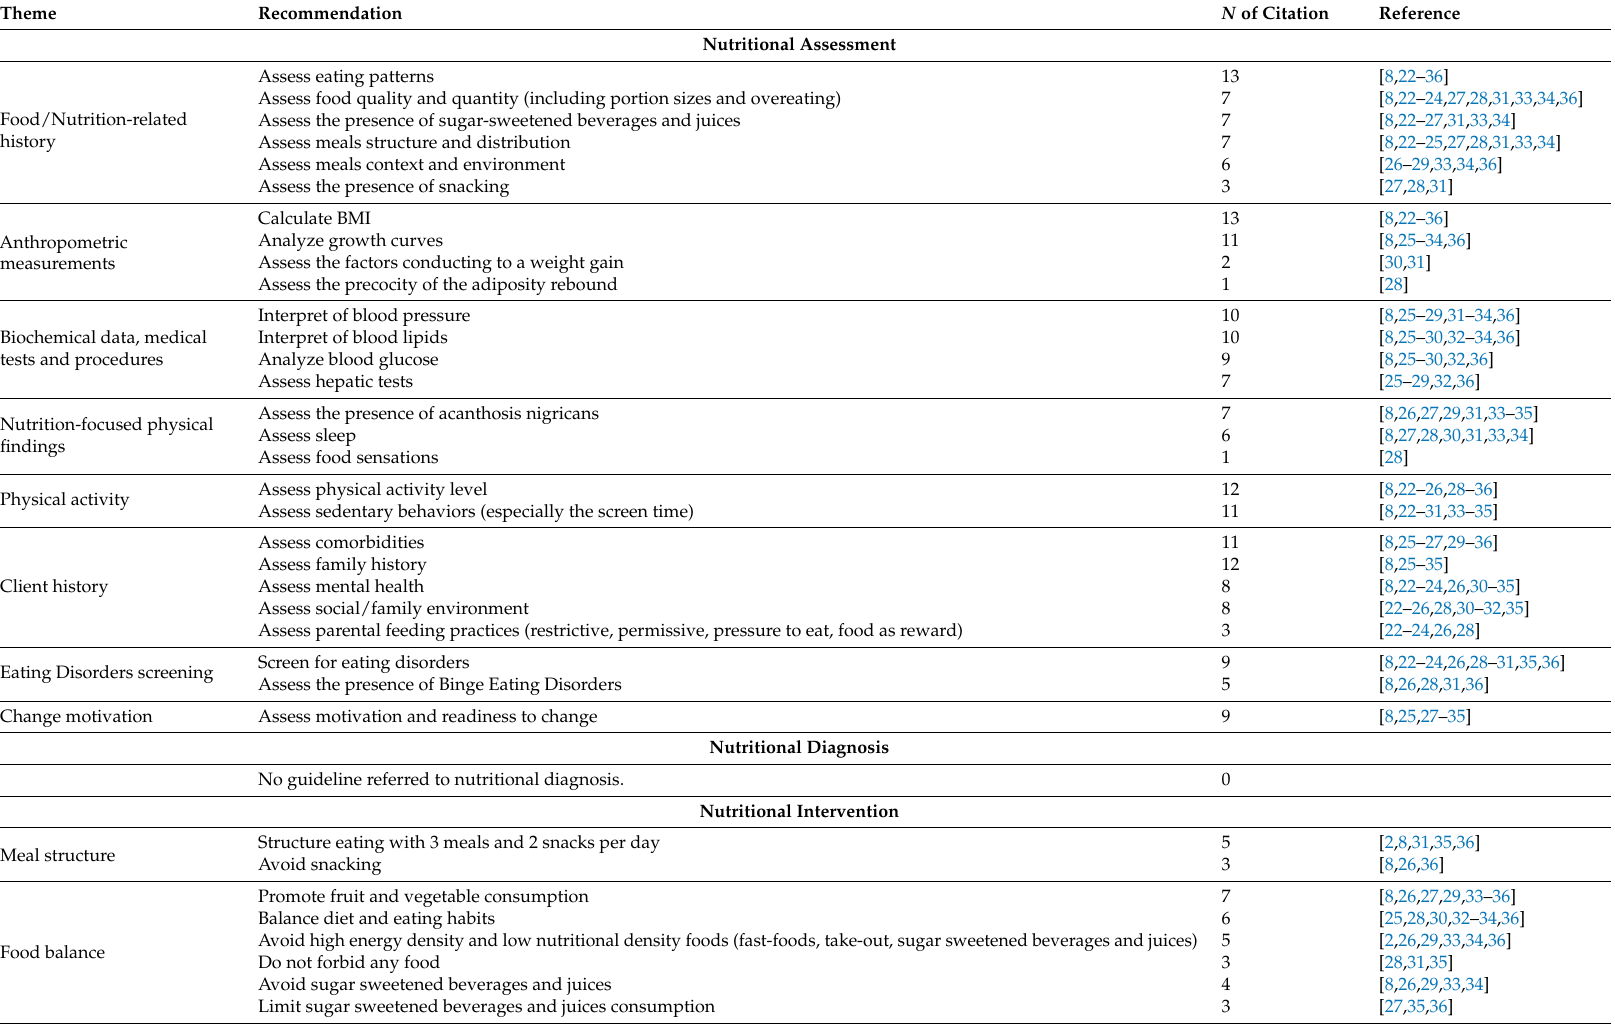
Table 2. Recommendations regarding nutritional assessment, diagnosis, intervention and monitoring and evaluation, frequency of citation and references of the 17 included